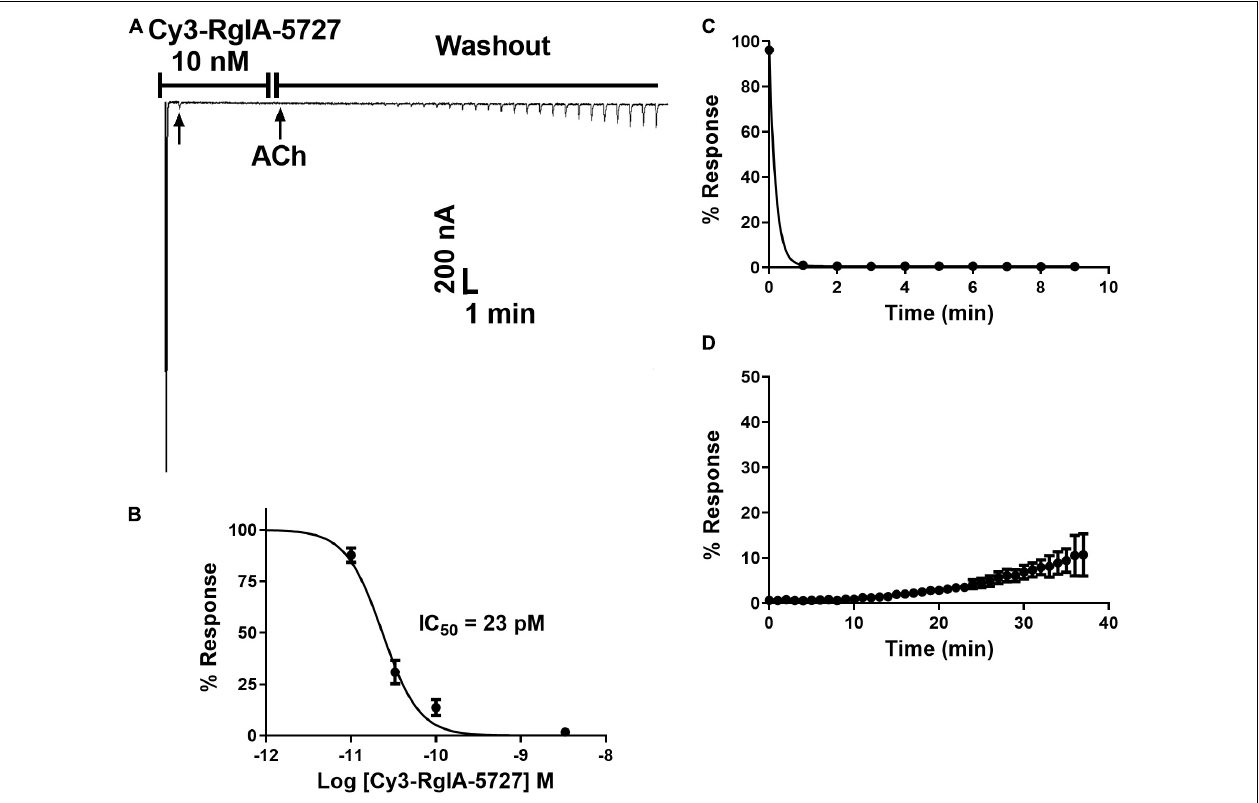
FIGURE 2 | Block and recovery from block of α 9 α 10 nAChRs by Cy3-RgIA-5727. (A) Cy3-RgIA-5727 (10 nM) was applied to Xenopus oocytes expressing mouse α 9 α 10 nAChRs as described in Section “Materials and Methods.” Recovery from block after removal of peptide is shown. (B) Concentration response analysis indicated an IC 50 of 23 pM (see Table 1 ); n = 3–4 oocytes. (C) Time course of block and (D) un-block by 10 nM Cy3-RgIA-5727; n = 3